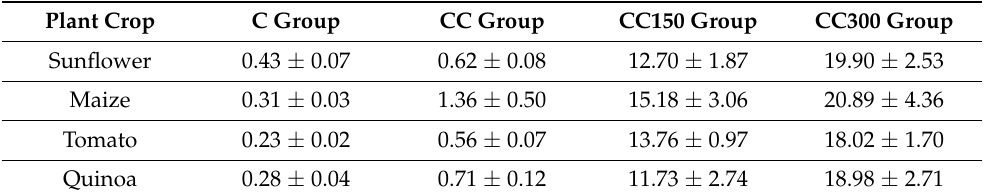
Table 1. Electrical conductivity of soils (dS · m − 1 ) reported as average ± standard deviation of the five replicates for each group.